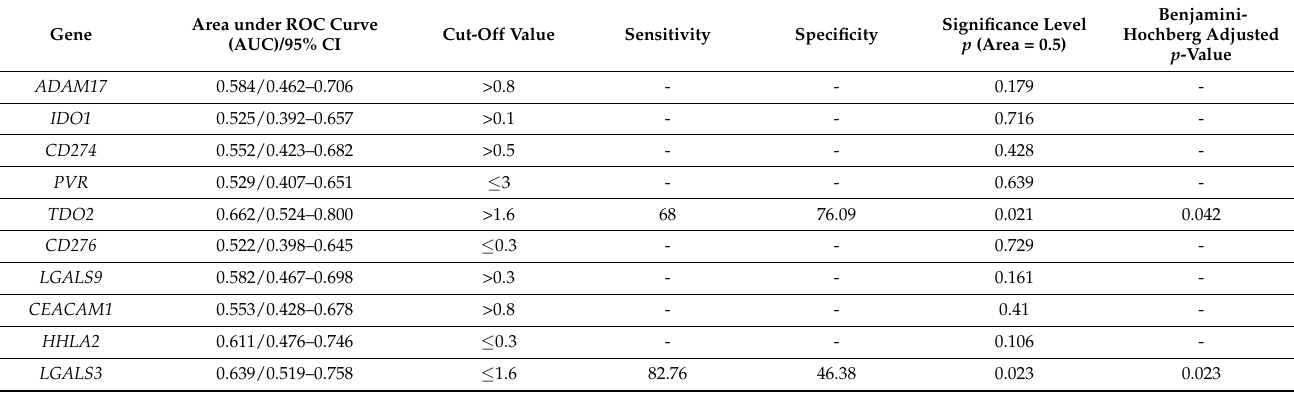
Table 2. The relationship of gene expression with the development of metastases using ROC anal- ysis.